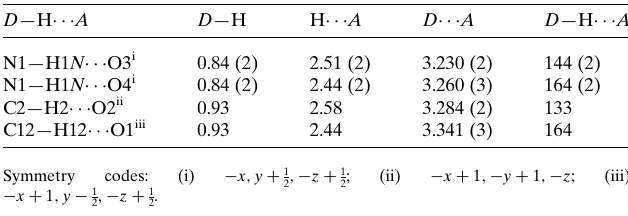
Table 2 Hydrogen-bond geometry (A˚ , (cid:4) ) for (II).